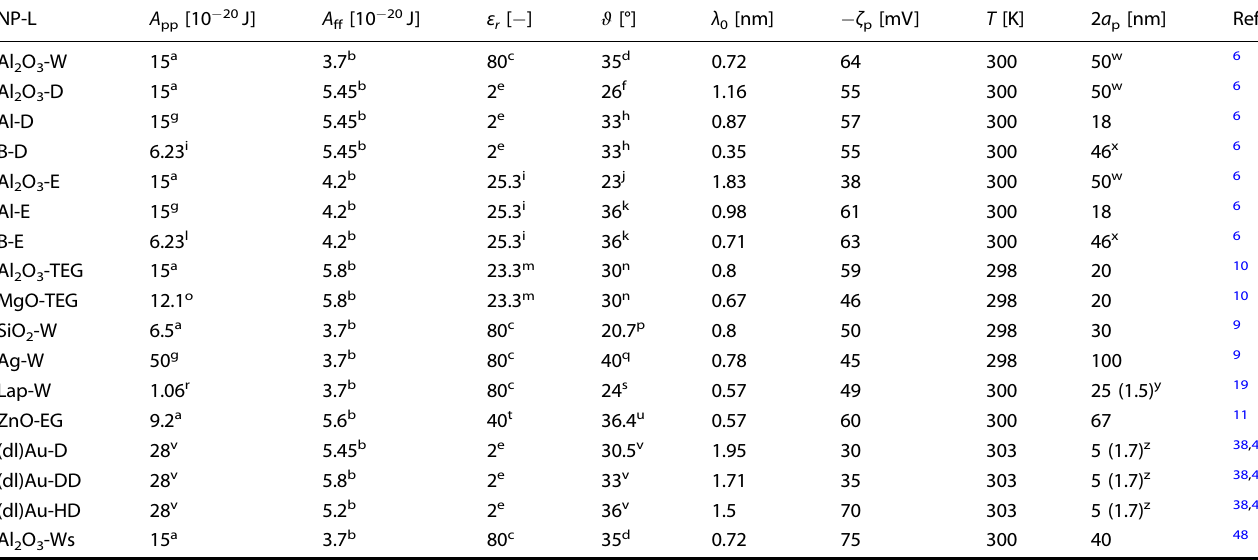
Table 2. Data needed for calculation of equilibrium constant K p